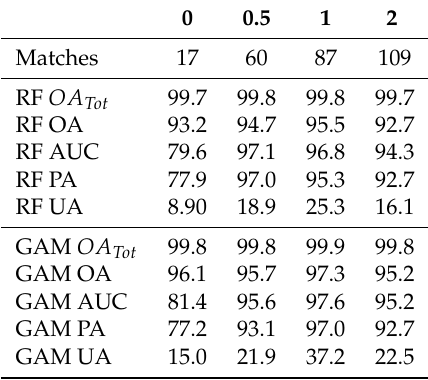
Table 3. Results of the different models of ravine forest predictions with respect to the weight of topography in the segmentation. Matches correspond to the number of ecotopes matching at more than 50 percent with biotopes survey polygons. The next rows show the different quality indices including the overall accuracy of ravine forest mapping in the study area ( OA Tot ), the Overall Accuracy (OA), Area Under the Curve (AUC), Producer Accuracy (PA) and User Accuracy (UA) of the ravine forests for each model based on ecotopes covered by a majority of broadleaved